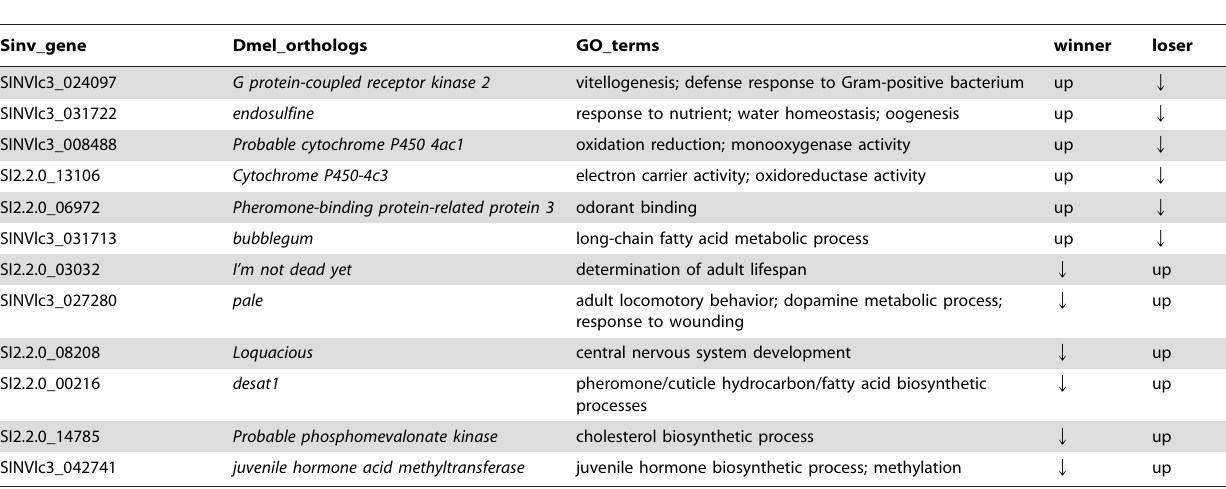
Table 1. Patterns of expression of the most relevant transcripts that were differentially regulated between winners and losers in experiment 1 (P ,